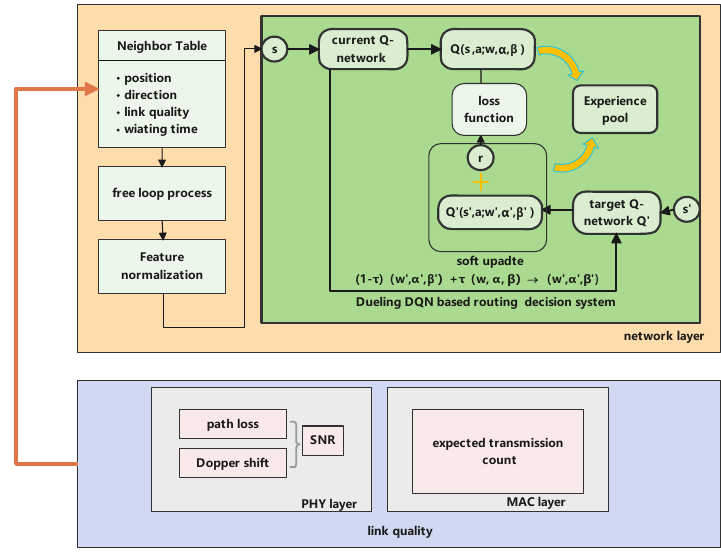
Figure 3. The framework for our proposed routing